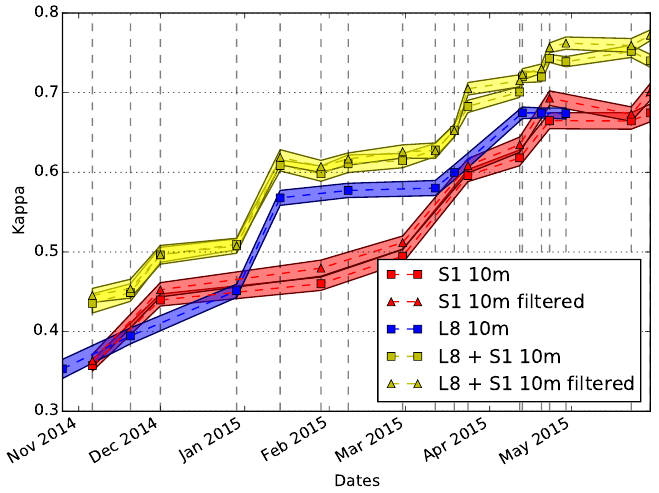
Figure 7. Comparison of classification accuracy with data resampled to 10 m with and without speckle